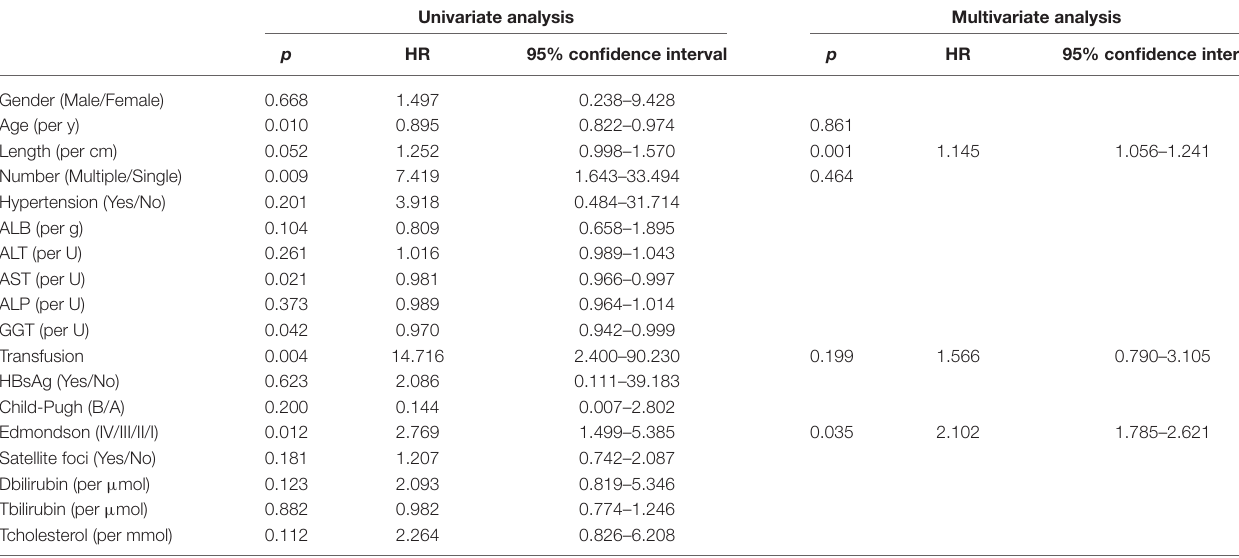
TABLE 4 | Univariable and multivariable Cox regression analyses of overall survival on BCLC-BC stages. Univariate analysis Multivariate